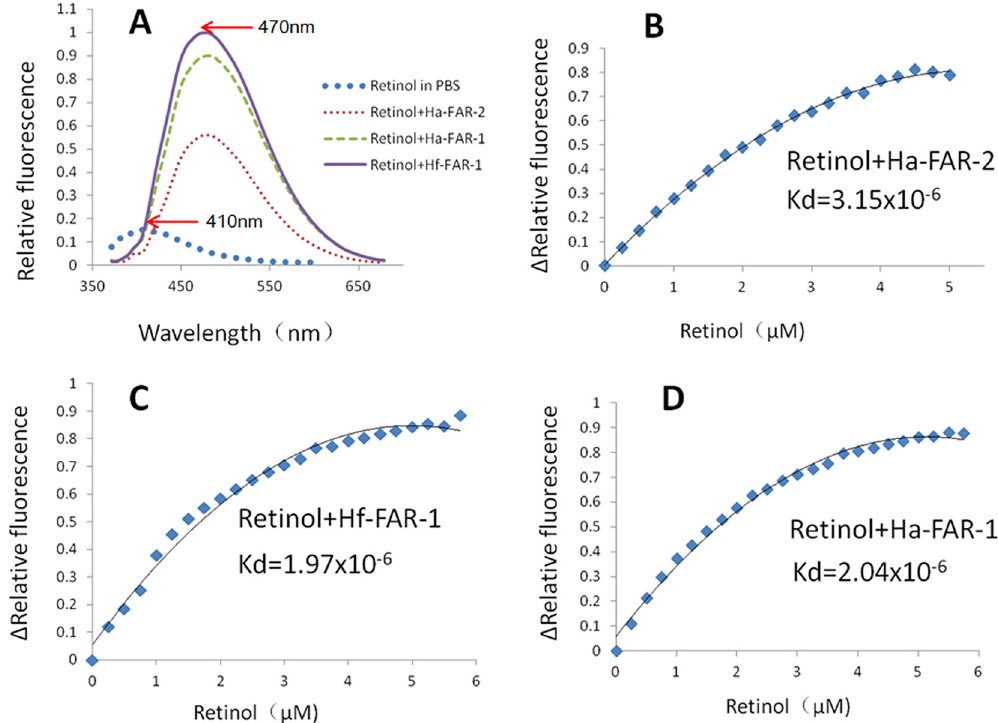
Fig 6. Diverse binding abilities to retinol of Ha-FAR-1,Ha-FAR-2 and Hf-FAR-1. A: Fluorescence emission spectra (excitation at 350 nm) of 10 μ M retinol in buffer alone or in buffer plus 2.5 μ M Ha-FAR-1 complex, 2.5 μ M Ha- FAR-2 complex or 2.5 μ M Hf-FAR-1 complex. Peak emission was at 470nm. B, C, D: Titration curves for determining the dissociation constant (Kd) for interaction of retinol with Ha-FAR-2, Hf-FAR-1 and Ha-FAR-1.